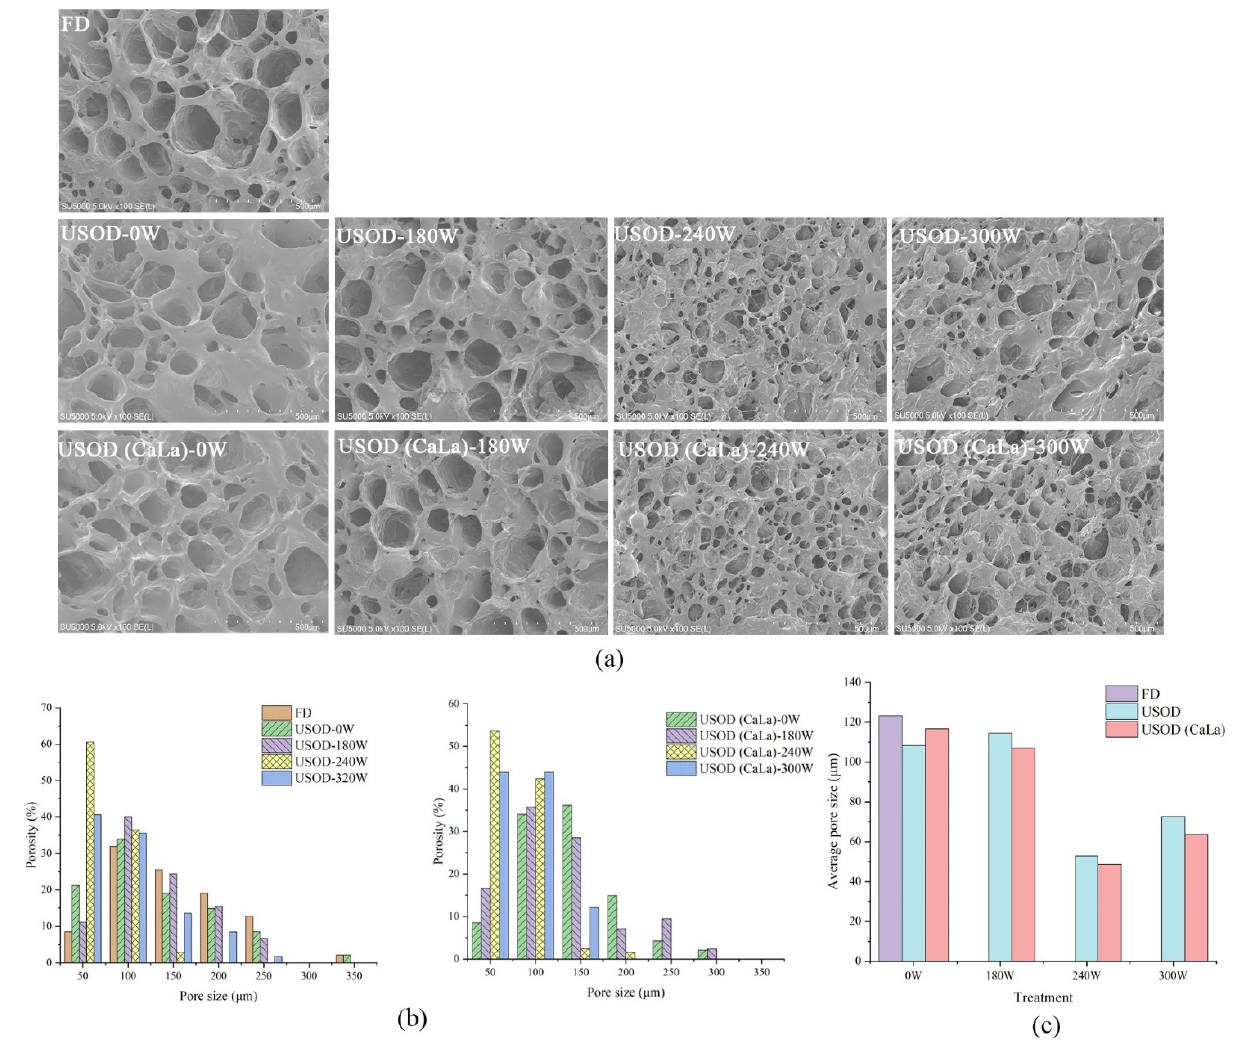
Figure 3. Scanning electron microscope observation (( a ), magnification ×100), pore size distribution ( b ) and average pore size ( c ) of freeze-dried yellow peach slices with different treatments.